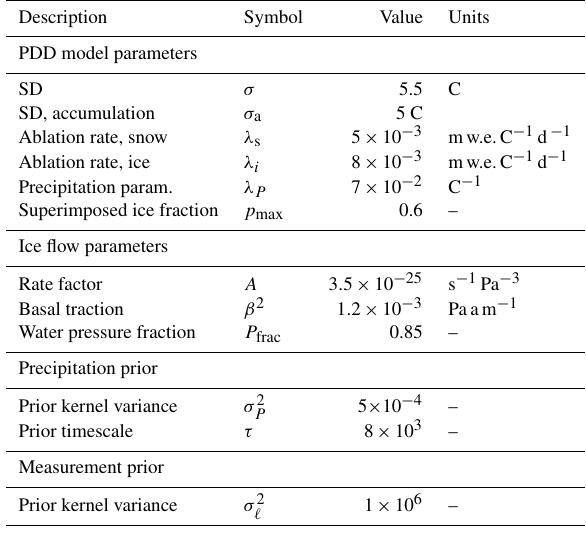
Table 1. Summary of primary model parameters used in this work. Default values are provided where applicable.